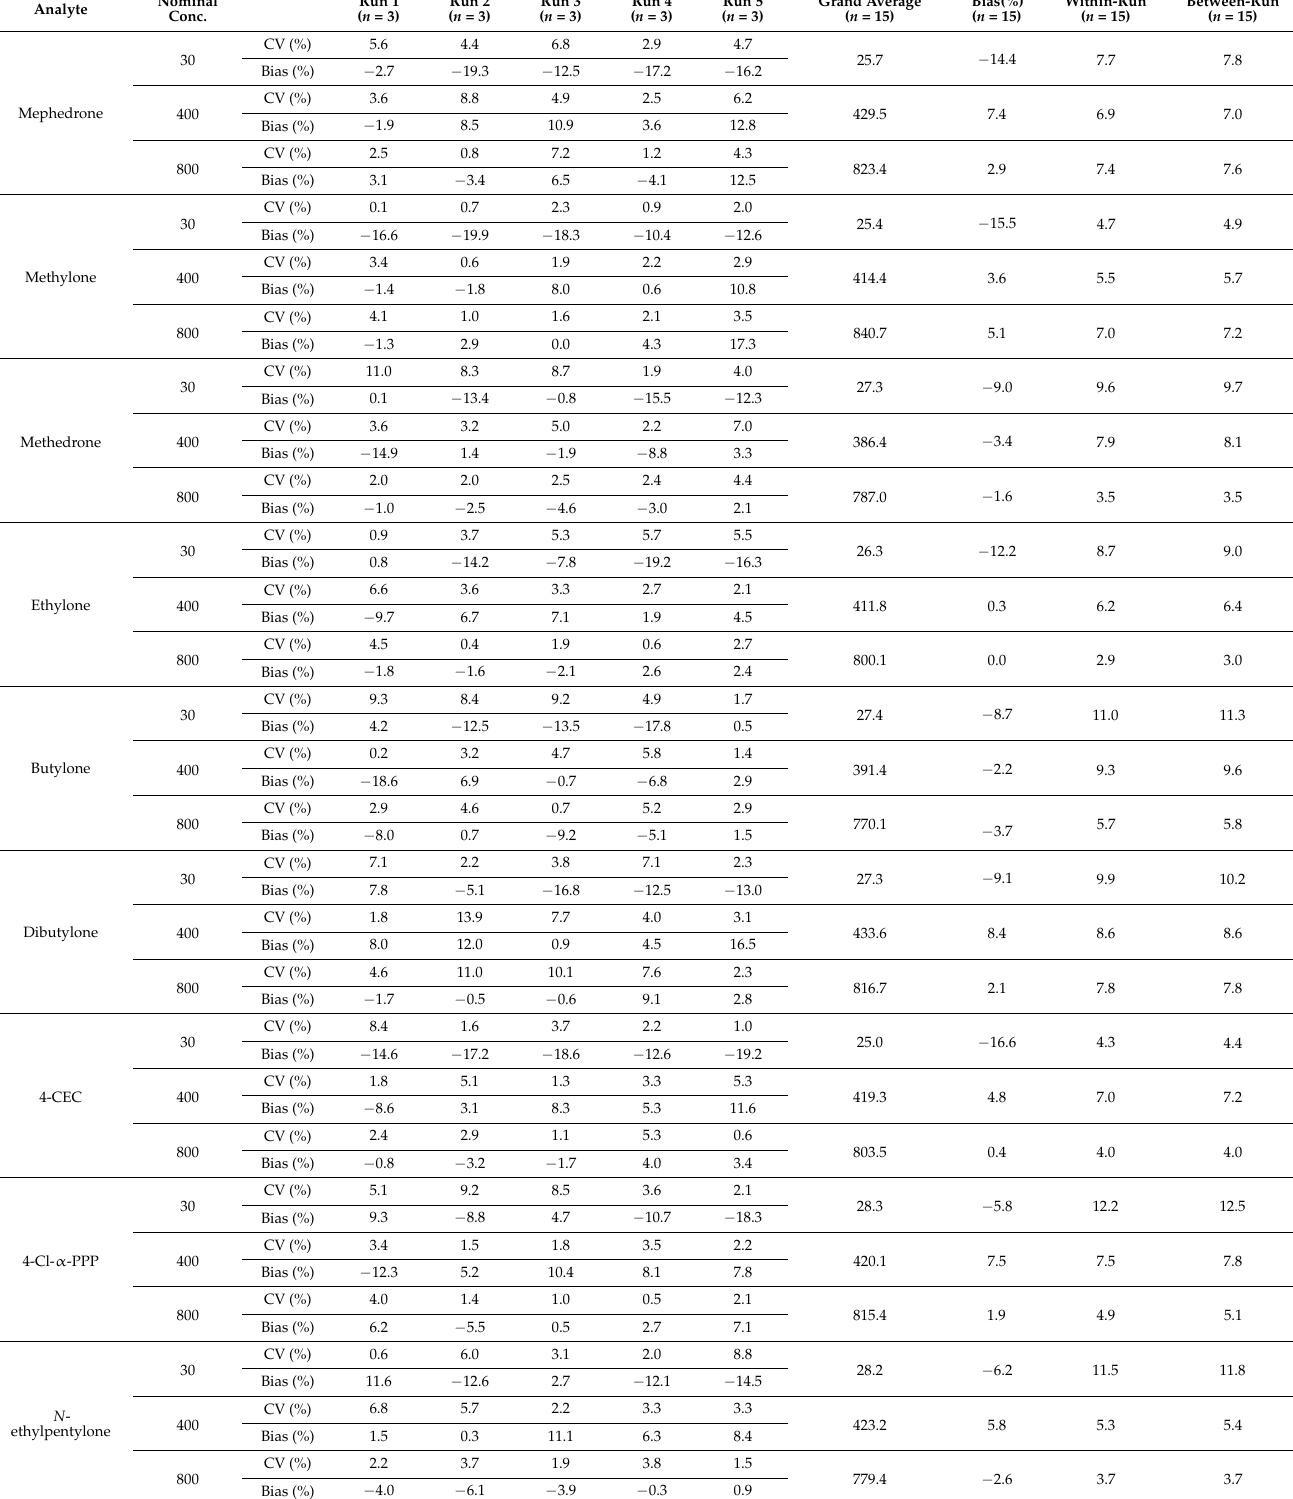
Table 3. Bias and precision for urine at QC-low (30 ng/mL), QC-medium (400 ng/mL) and QC-high (800 ng/mL)